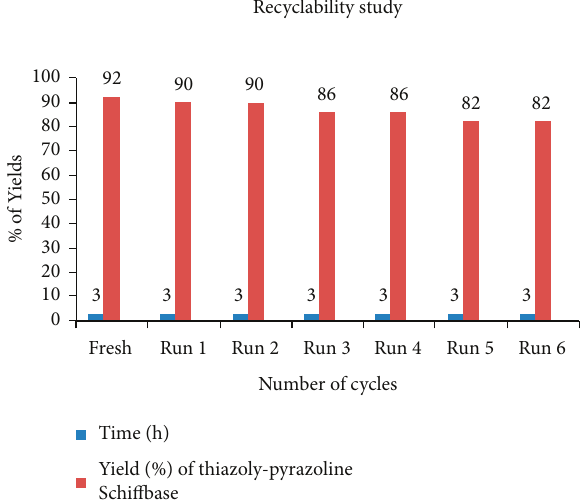
Figure 1: Synthesis of thiazolyl-pyrazoline Schiff base hybrids from chalcone catalyzed by ZnO NPs was investigated for